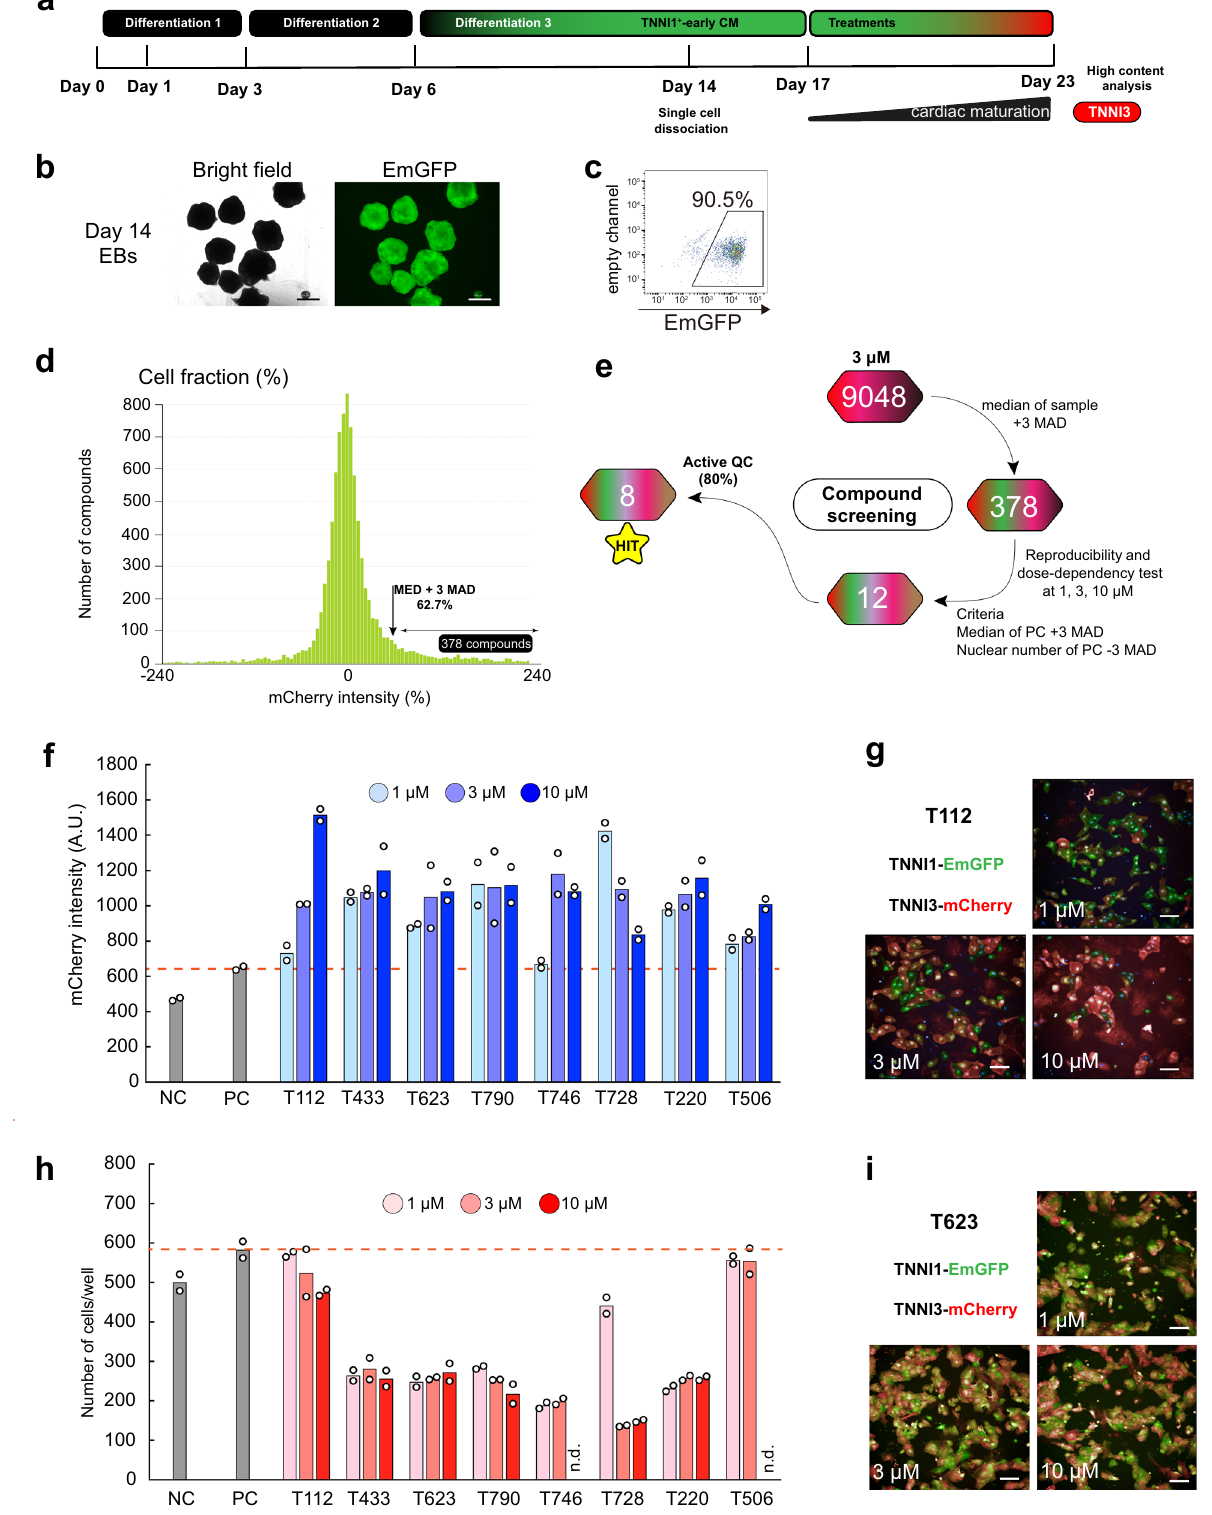
Fig. 2 Molecular screening for TNNI3 mCherry expression. a Schematic representation of the cardiac differentiation protocol for cardiac maturation monitoring. b Bright fi eld (left) and EmGFP fl uorescence (right) images of day-14-derived EBs. Scale bars: 500 μ m. c Flow cytometric analysis of day-14- derived EBs for TNNI1 EmGFP . d Compounds were selected by the median (MED) plus 3 MAD. e Screening outline of the chemical compounds. f High content imaging for mCherry dose-dependency intensity. n = 2 biologically independent samples per group. g Dose-dependent T112-derived fl uorescence for TNNI1 EmGFP and TNNI3 mCherry . Scale bars: 100 μ m. h Dose-dependent cell number per well after treatment. n.d. not detected. n = 2 biologically independent samples per group. i Dose-dependent T623-derived fl uorescence for TNNI1 EmGFP and TNNI3 mCherry . Scale bars: 100 μ